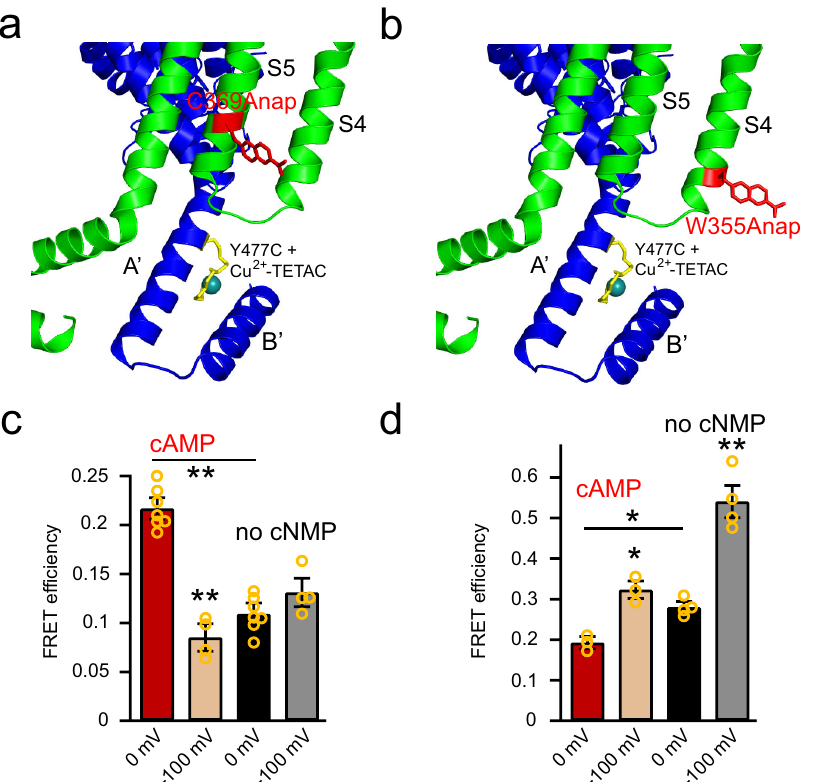
Fig. 3 tmFRET between the N-terminal end of the S5 helix and A ′ helix of the C-linker. a Cartoon showing tmFRET between C369Anap in the S5 helix and Cu 2 + -TETAC attached to Y477C in the A ′ helix. b Cartoon showing tmFRET between W355Anap in the S4 helix and Cu 2 + -TETAC attached to Y477C in the A ′ helix. c FRET ef fi ciencies of spHCN-C369Anap, Y477C channels measured in four conditions: the presence and absence of cAMP, and at 0 and − 100 mV; n = 7 independent patches for 0 mV conditions and n = 4 independent patches for − 100 mV conditions. ** p < 0.001; p = 0.1 between no cNMP, 0 mV and no cNMP, − 100 mV conditions. d FRET ef fi ciencies of spHCN-W355Anap, Y477C channels measured in four conditions: the presence and absence of cAMP, and at 0 and − 100 mV; n = 3 independent patches for cAMP and n = 4 independent patches for no cNMP. ** p < 0.001 and * p < 0.05. Data shown are mean ± s.e.m.; source data are provided in the Source Data fi